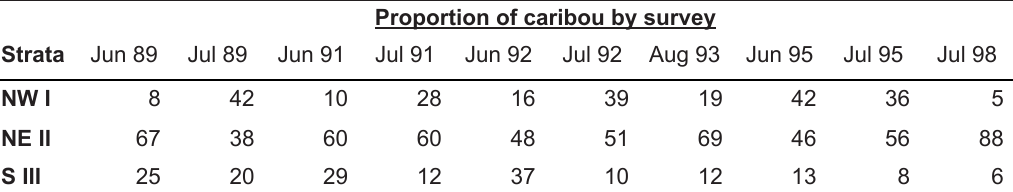
Table 2. Proportion of caribou observed corrected for effort (flying time) relative to the three survey strata on Bathurst Island during unsystematic surveys in June, July and August 1989-1998, Nunavut (Miller 1991; 1993; 1994; 1995a; 1997; Miller & Gunn,